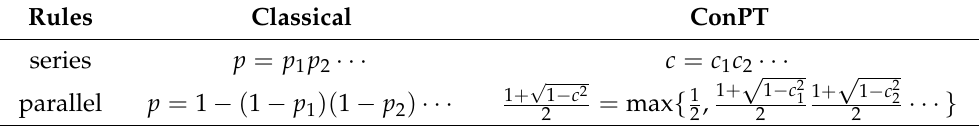
Table 1. Connectivity